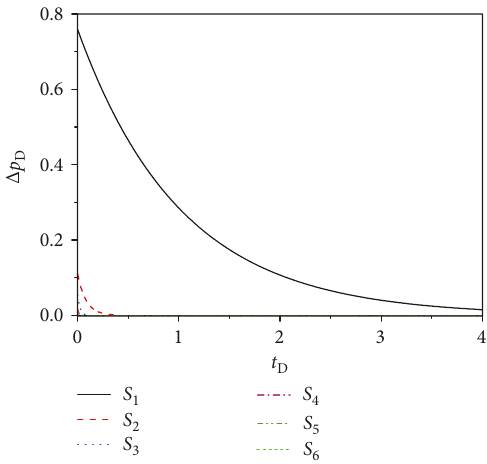
Figure 2: The fi rst six terms of the series in equation (6) ( a = 1 and b = 0 2 ).